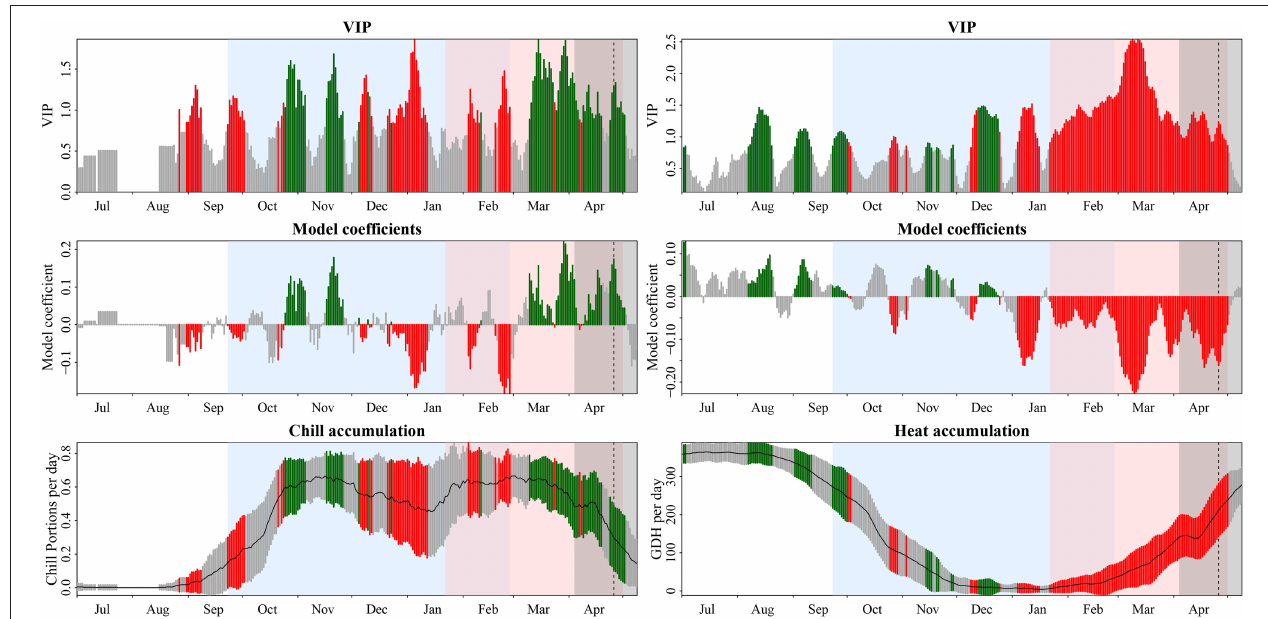
FIGURE 1 | Results of Partial Least Squares (PLS) regression analysis for budburst dates of grapevine cv. ‘Riesling Italico’ in Mandicevac (Croatia), using the Dynamic Model and the GDH Model for quantifying chill and heat accumulation, respectively (historical data from 1961 to 2013). Color bars in the figures indicate VIP above 0.8, the threshold for considering variables important. Green and red bars represent, besides importance, a positive and negative relationship, respectively, between budburst and daily chilling and heat accumulation. In the lower graphs (chill accumulation and heat accumulation), bars represent the standard deviation of daily chill and heat accumulation, with colors following the same pattern as for the variable importance in the projection (VIP) and model coefficients. Blue, red, and gray shaded areas and dashed lines represent the designated chilling and warming period, range in budburst dates and average budburst date, respectively. GDH, Growing Degree